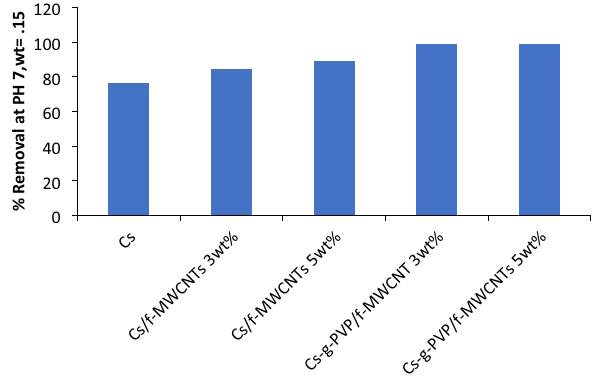
Figure 7. Removal efficiency % by Cs, Cs/f-MWCNTs hybrids containing 3wt% and 5wt% by weight of f-MWCNTs and Cs-g-PVP/f-MWCNTs hybrids containing 3wt% and 5wt% by weight of f-MWCNTs using 0.15 g adsorbent at pH